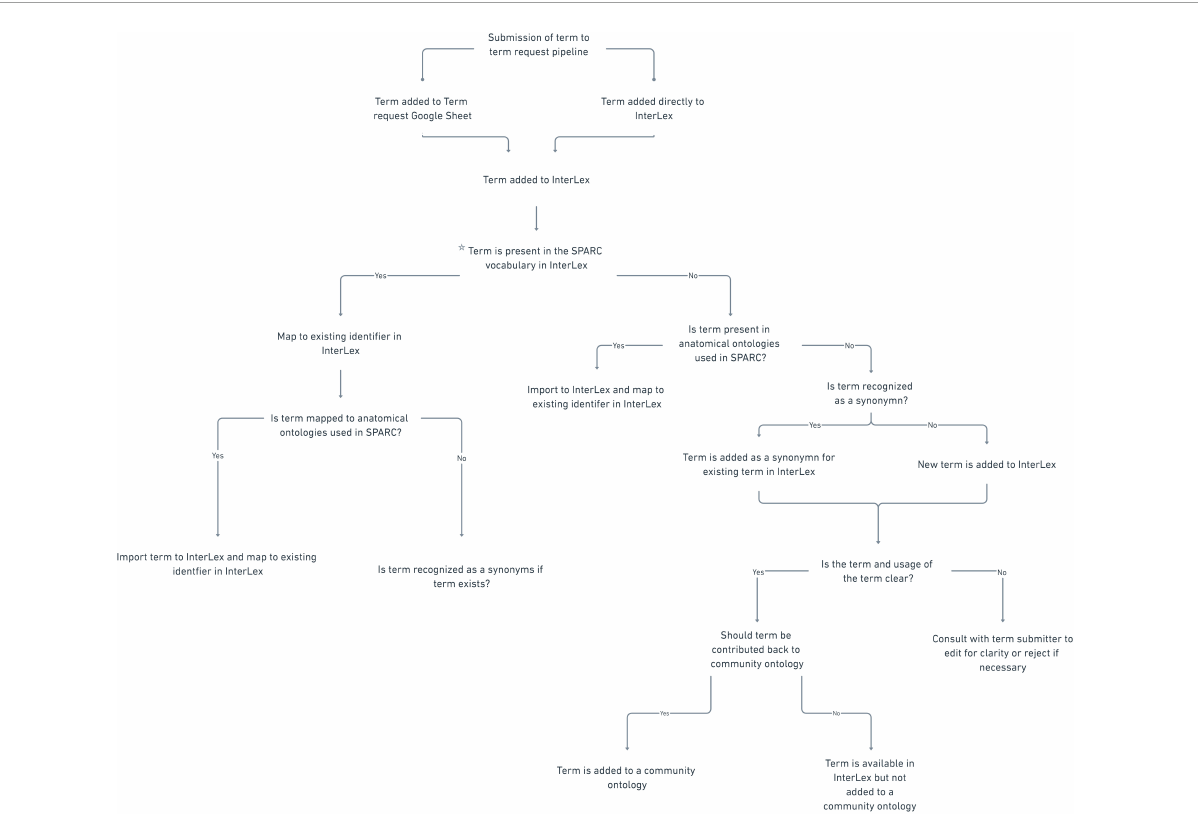
FIGURE8 Disposition of all terms submitted to the term request and review pipeline as of August 2021. The star in the figure notates the 10 terms labeled as “not in InterLex.” This label refers to terms that were added to the pipeline but were either not added to the SAWG community or depreciated from InterLex, a subset (SAWG community) of the vocabulary in InterLex via free-text